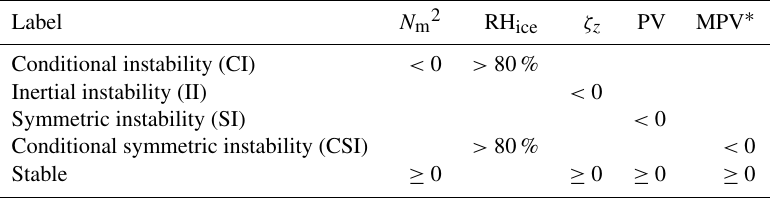
Table 1. Criteria for trajectory instability and stability labels. N m2 is the moist Brunt–Väisälä frequency as defined by Durran and Klemp (1982). ζ z is the vertical component of absolute vorticity (on pressure levels). PV is the potential vorticity and MPV ∗ the moist saturated potential vorticity (Bennetts and Hoskins, 1979). Multiple entries in a row require all criteria to be satisfied (i.e. “and” rather than “or”).